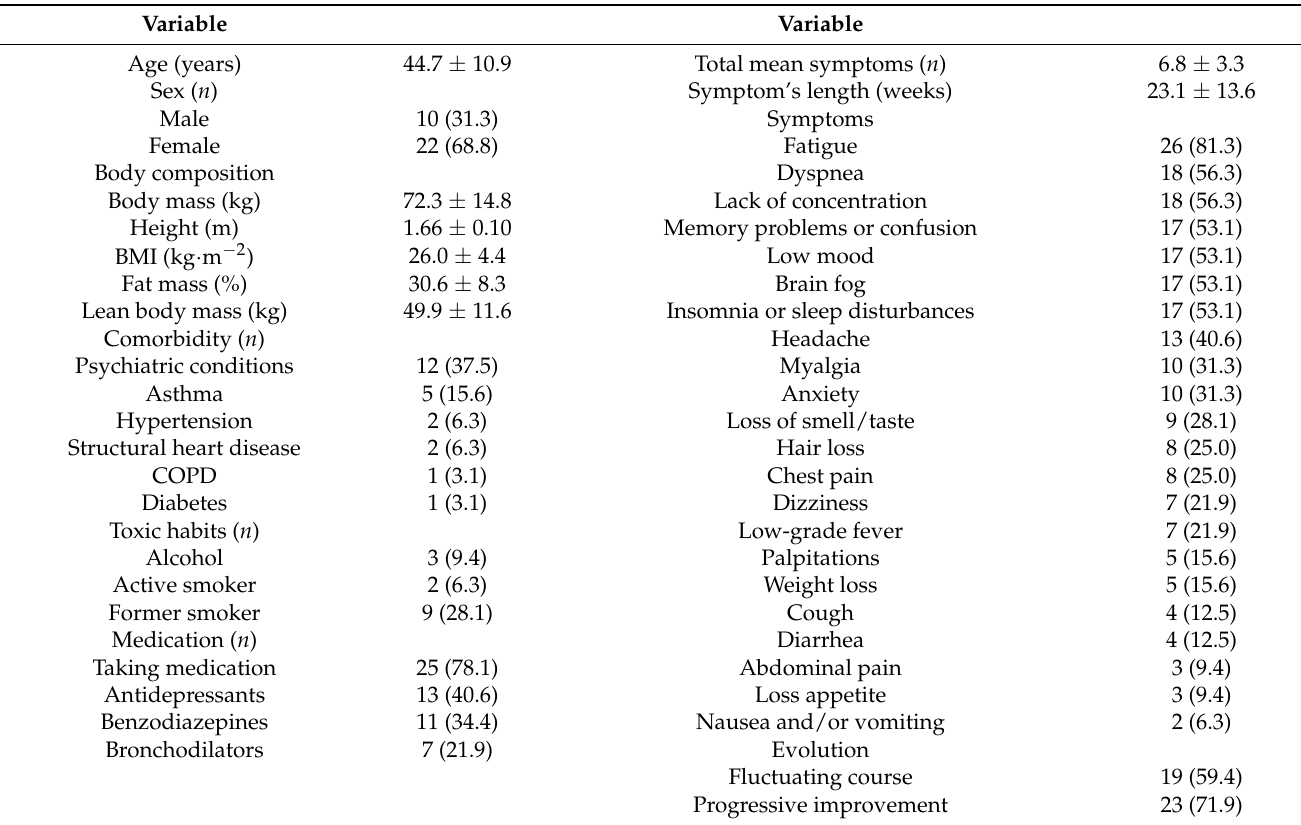
Table 1. Characteristics, clinical history, and symptomatology of recruited patients with post-COVID-19 syndrome ( n = 32). Variable